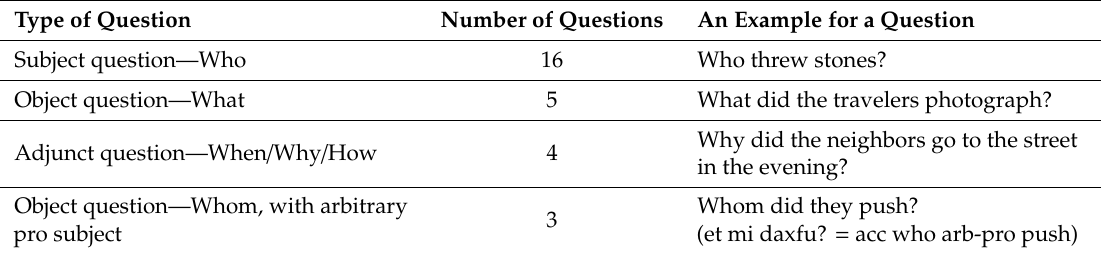
Table A4. Types of comprehension